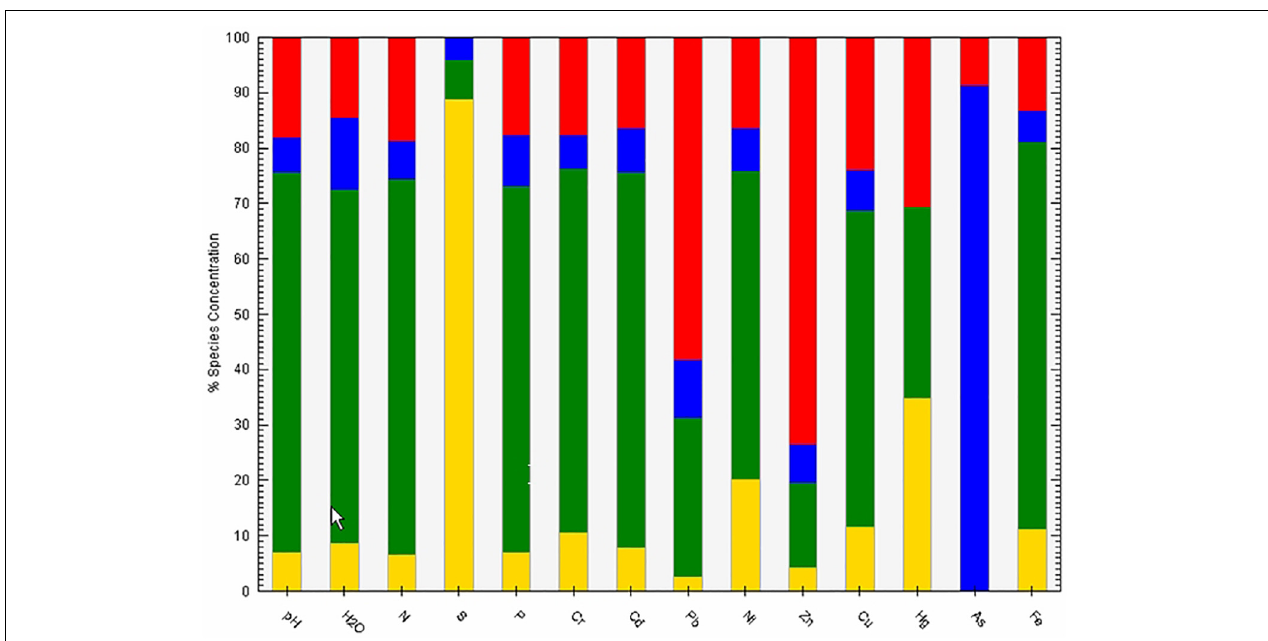
FIGURE 6 | Factor fingerprints of metals resulting from the PMF model. Factor 1 (red color); Factor 2 (blue color); Factor 3 (green color); Factor 4 (yellow color).